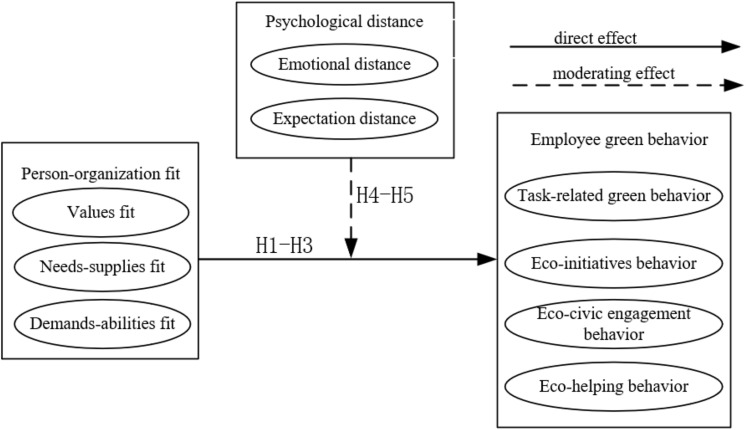
Conceptual model.